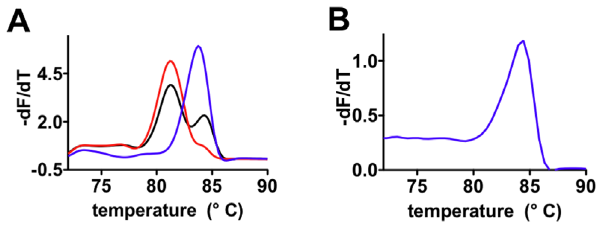
by sequence polymorphisms in the introns or in the 5 9 or 3 9 untranslated regions that flank the exons and introns are distinguished by the use of a fourth set of digits. The primer mix used in figure 6 is specific for all alleles of the HLA-DRB1 types (digits before the first colon) 03, 11, 13 and 14. All other alleles should not be amplified.